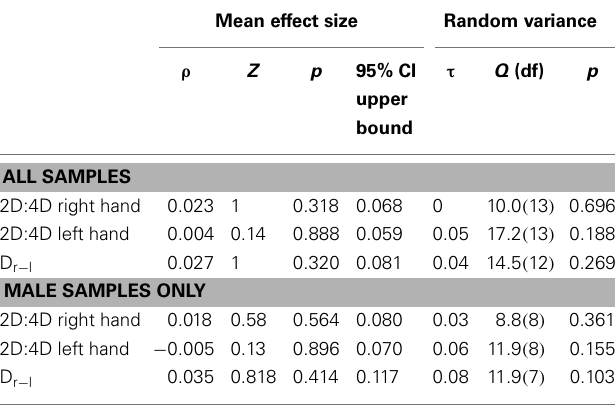
Table 3 | Results of meta-analyses for the relationship between CAGn and 2D:4D